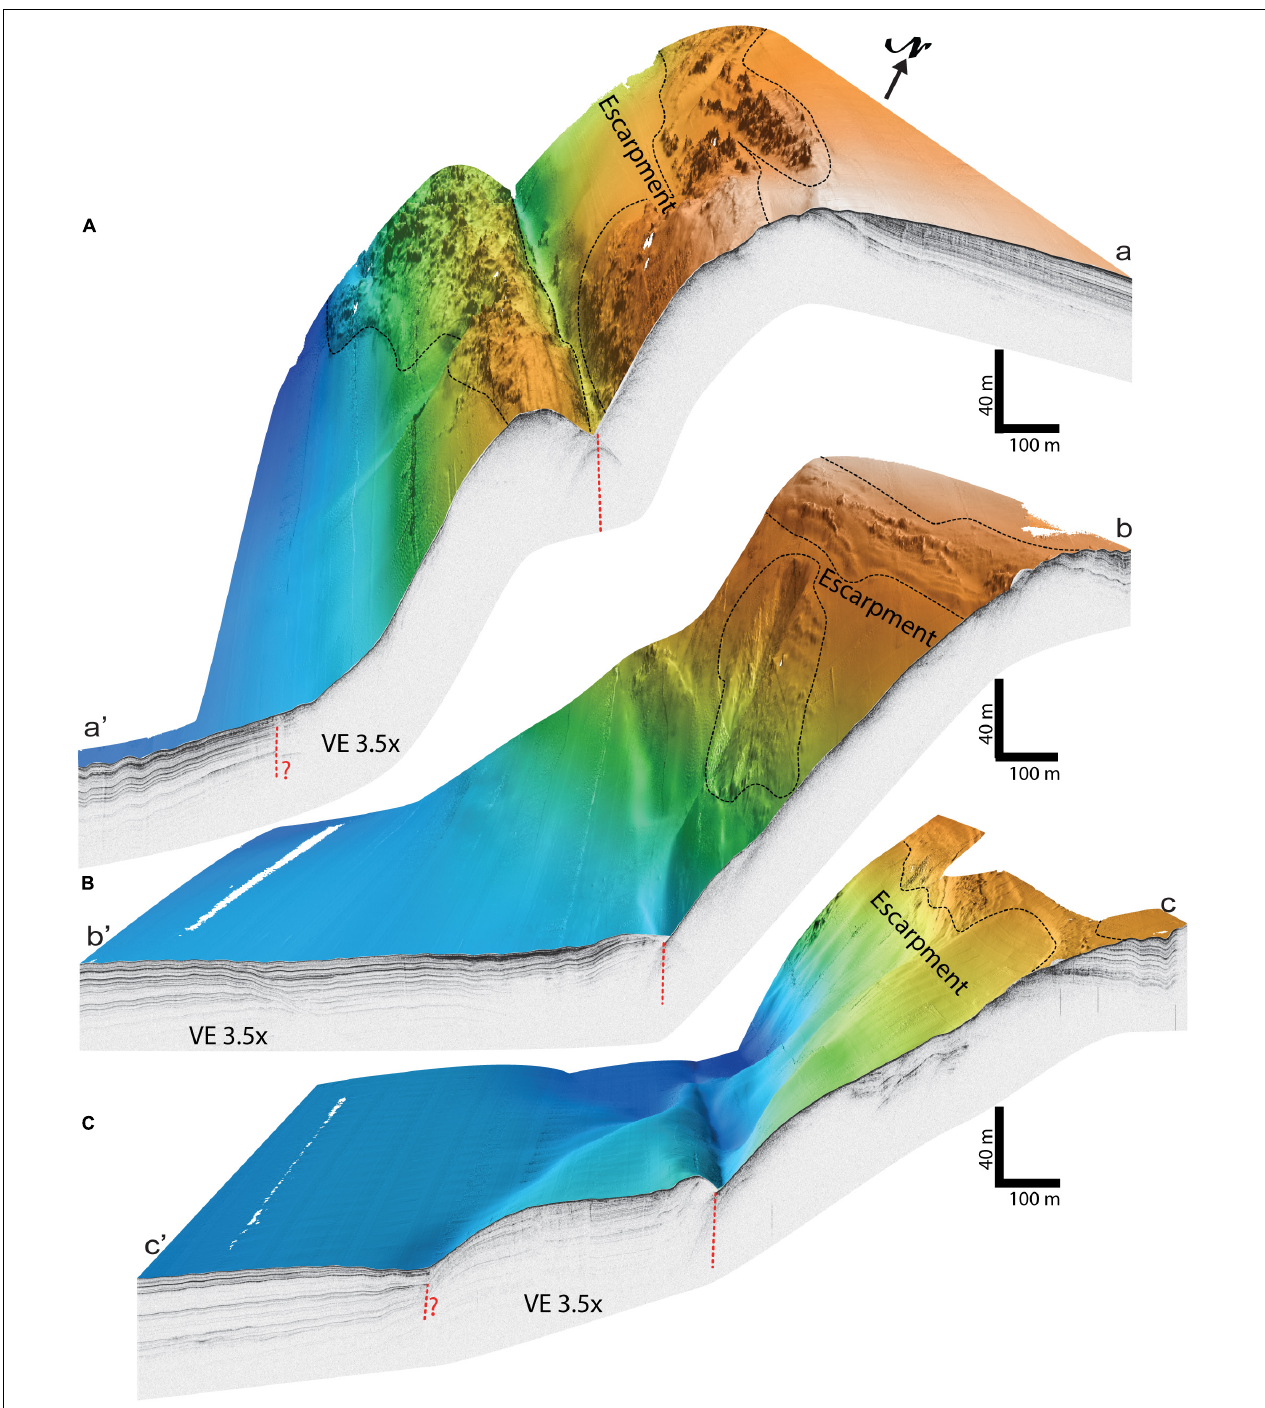
FIGURE 3 | Composite figure showing chirp profiles approximately placed on a perspective view of AUV collected bathymetry at the San Clemente Fault. Location of chirp lines shown in A–C are indicated in Figure 1D . Faults are shown as dashed red lines. Black dashed lines encircle areas with rough morphology indicative of barite